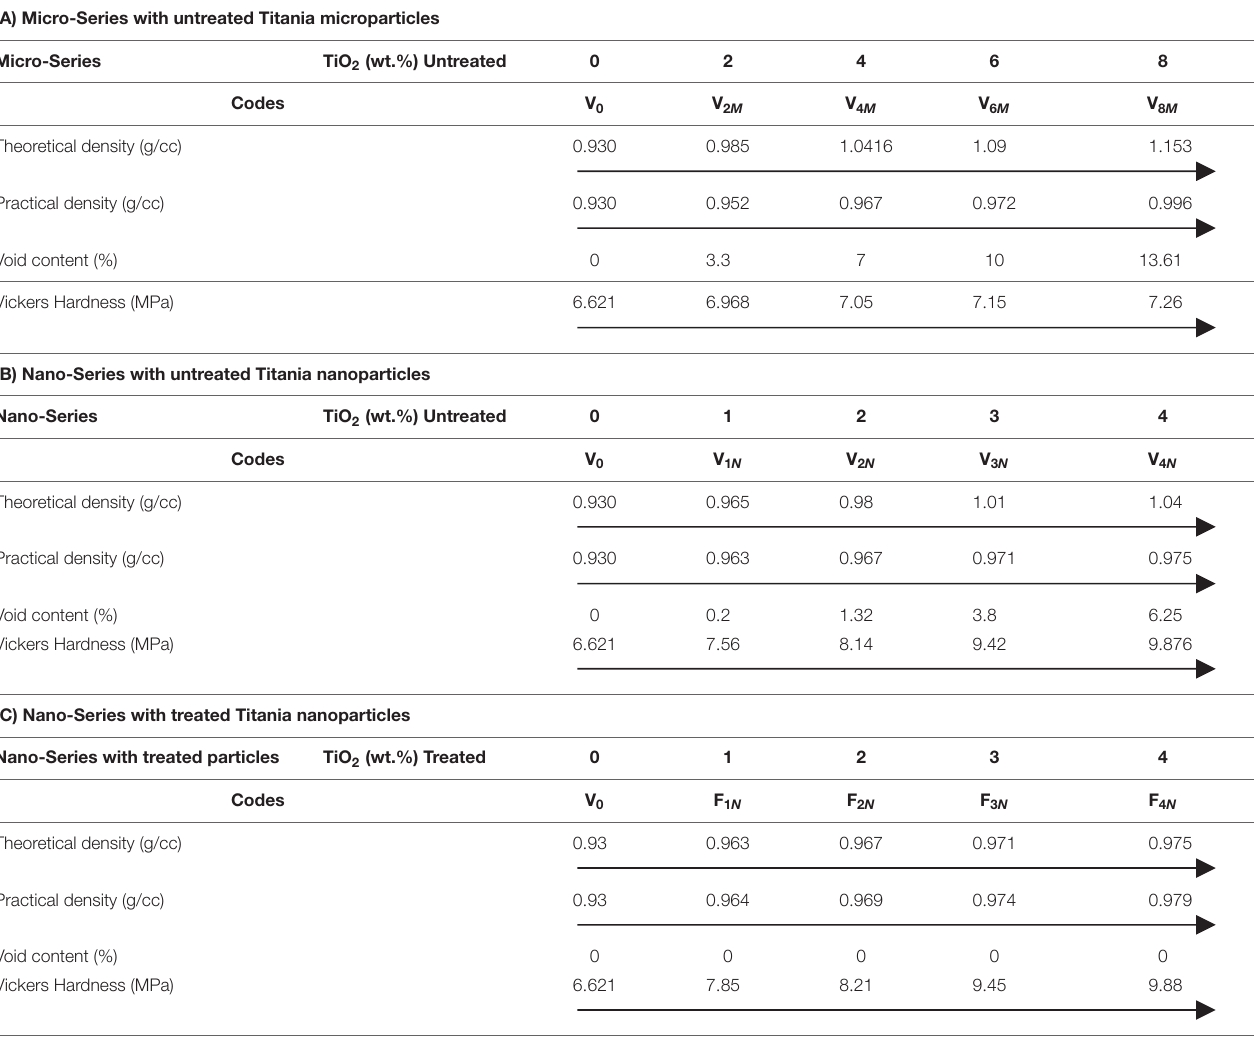
TABLE 3 | Composition and coding of